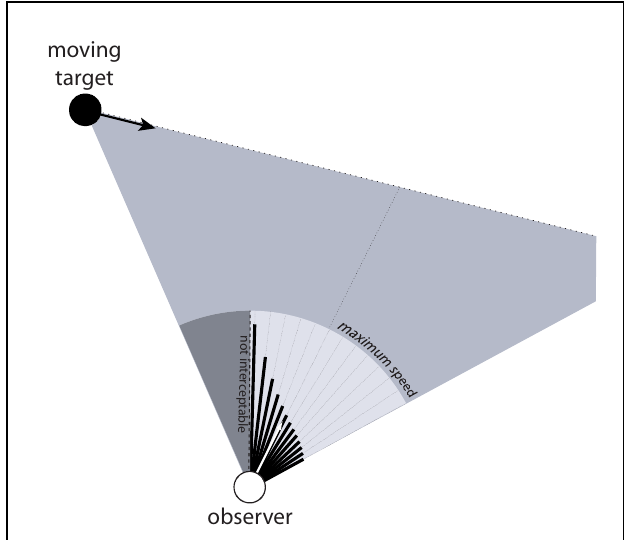
FIGURE 5 | Moving observer and moving target. The black lines emanating from observer represent the optically specified speed required to intercept the moving target by moving in the corresponding direction. The light gray circular sector corresponds to the observer’s maximum speed and the dark gray sector corresponds to directions for which interception is not possible because required speed exceeds maximum